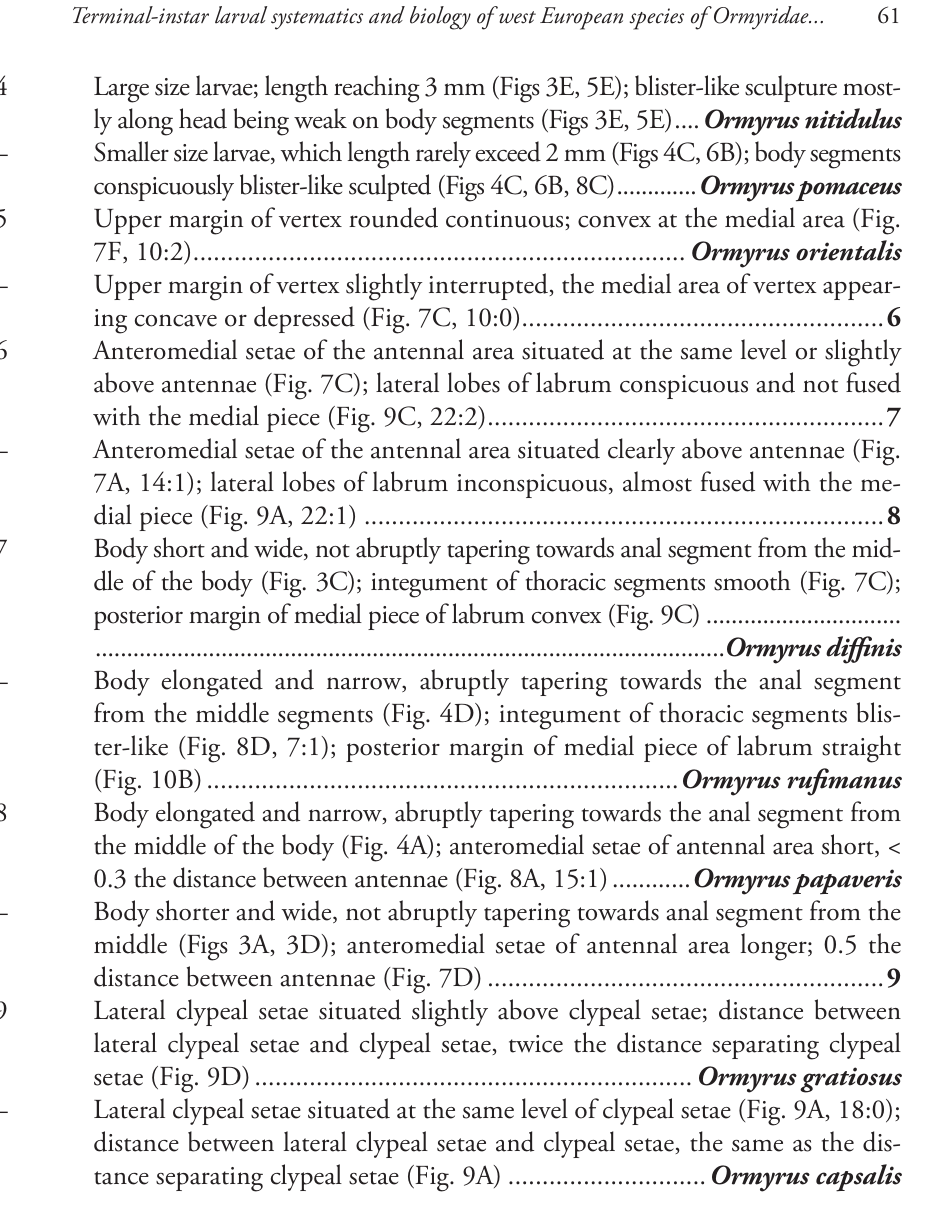
Descriptions of terminal larvae and biology of Ormyrus species Ormyrus capsalis Askew,